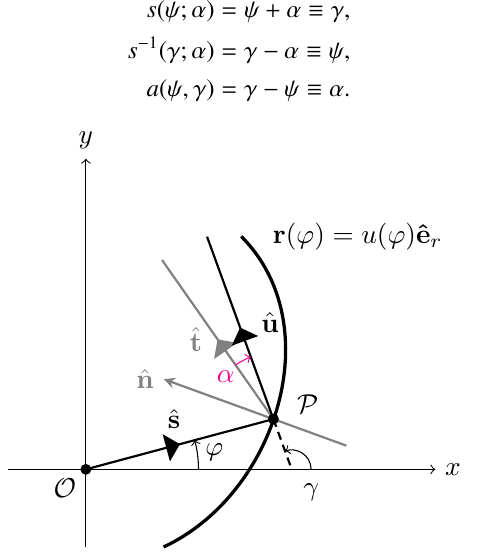
Figure 1. Cross-section of a di ff use cylindrically symmetric re- flector in the plane of